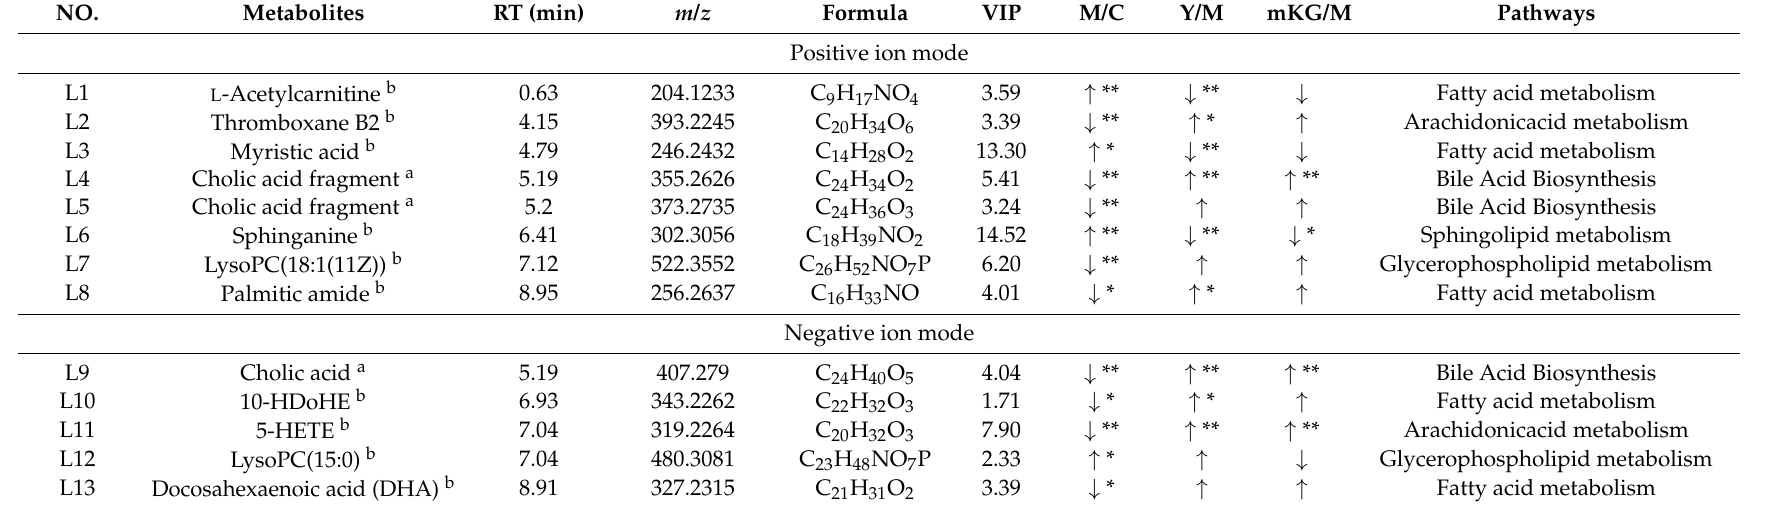
Table 2. Potential biomarkers characterized in the lung tissue profile and their change trends in different